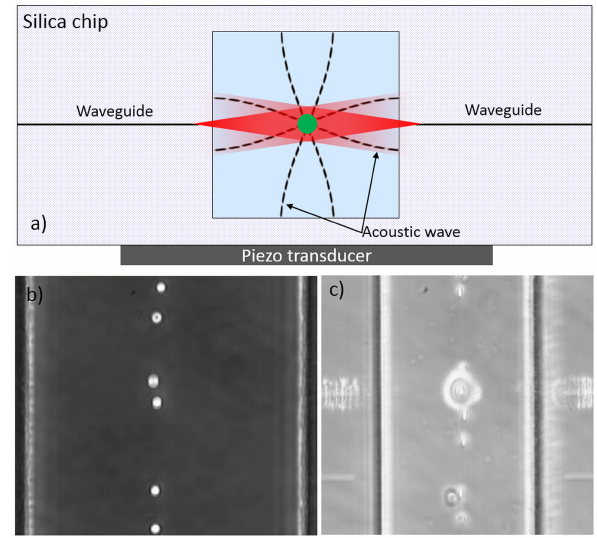
Figure 24. Acoustic prefocusing for optical stretcher. ( a ) Schematic illustration of the all glass microchip with both acoustic actuation (the black dash lines) driven by the underneath piezo ceramic and optical radiation (the red shaded area) emanating from the integrated waveguides. The microfluidic channel has a square cross section, 150 µm ×150 µm; ( b ) Microscope image of polystyrene beads trapped by acoustic wave in the middle of the microfluidic channel both horizontally and vertically (all beads are in the same focus); ( c ) Microscope image of red blood cells prefocused with acoustic wave for continuous optical stretching. Two opposing lasers from the waveguides are visible because of the light